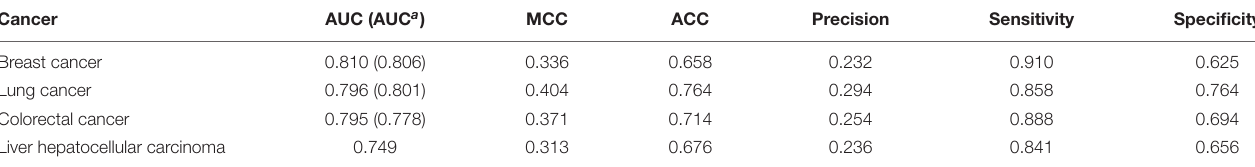
TABLE 2 | The performance of DRACA in the prediction of associations between lncRNA and three types of cancers.